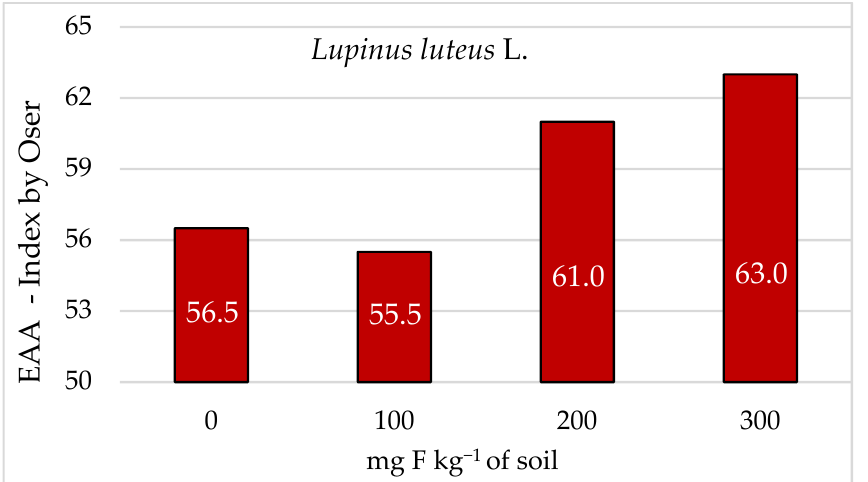
Figure 2. Nutritive value of protein accumulated in the aerial mass of yellow lupine depending on fluorine application to soil.